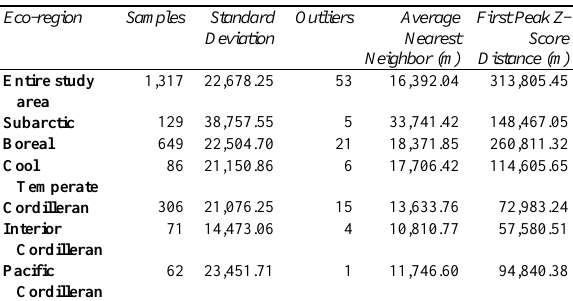
Table 2. Optimal distance for spatial analysis